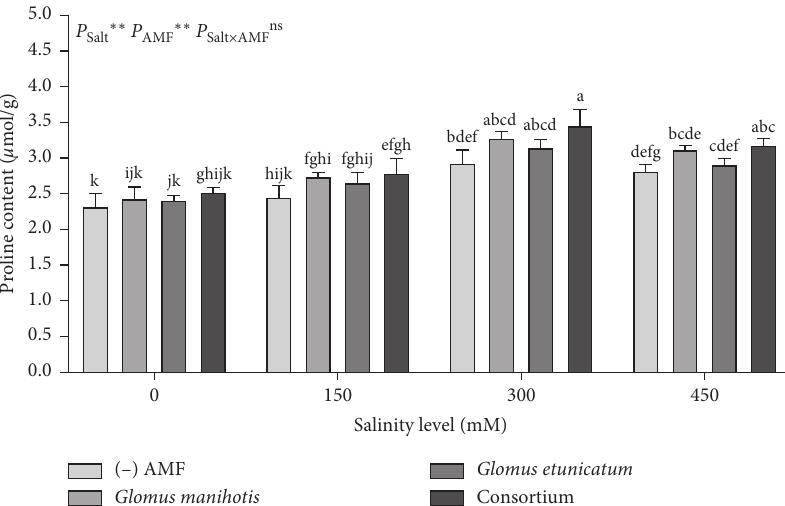
Figure 6: Effects of AMF inoculation on the proline content of L. leucocephala leaves at different NaCl stress. AMF: arbuscular mycorrhizal fungi. ∗ : significant at 0.01 ≤ P ≤ 0 . 05; ∗∗ : significant at P ≤ 0 . 01. Bars that do not share a letter are significantly different at P ≤ 0 . 05.